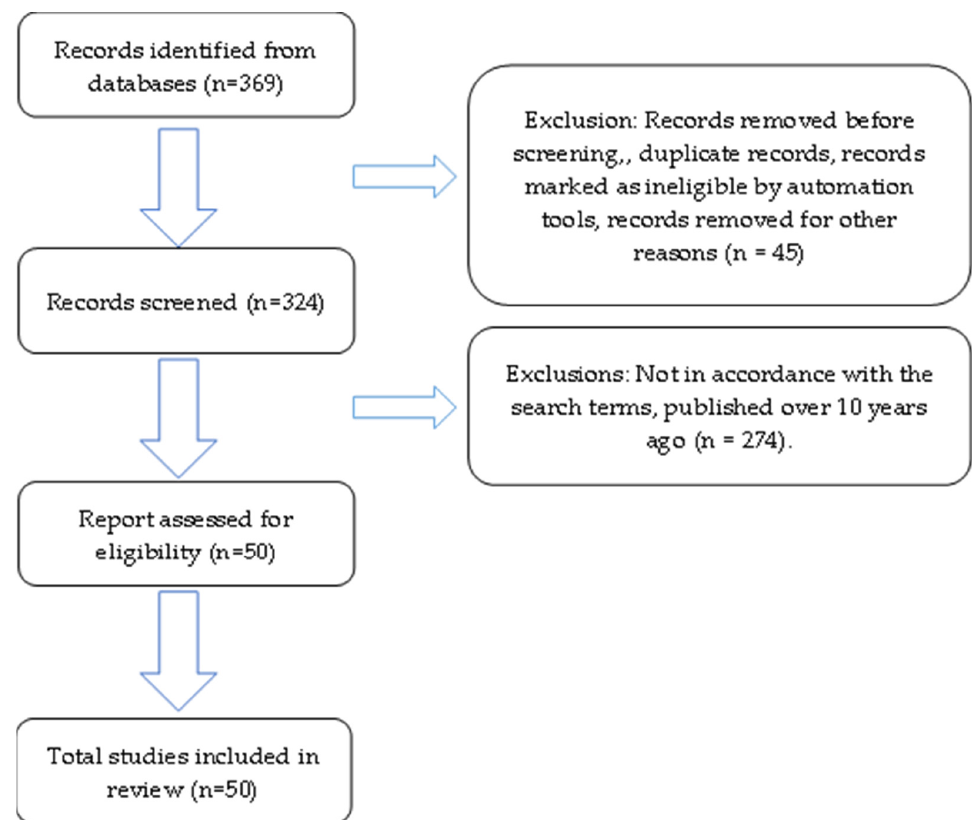
Figure 2. Flow diagram demonstrating the screening method for the article.